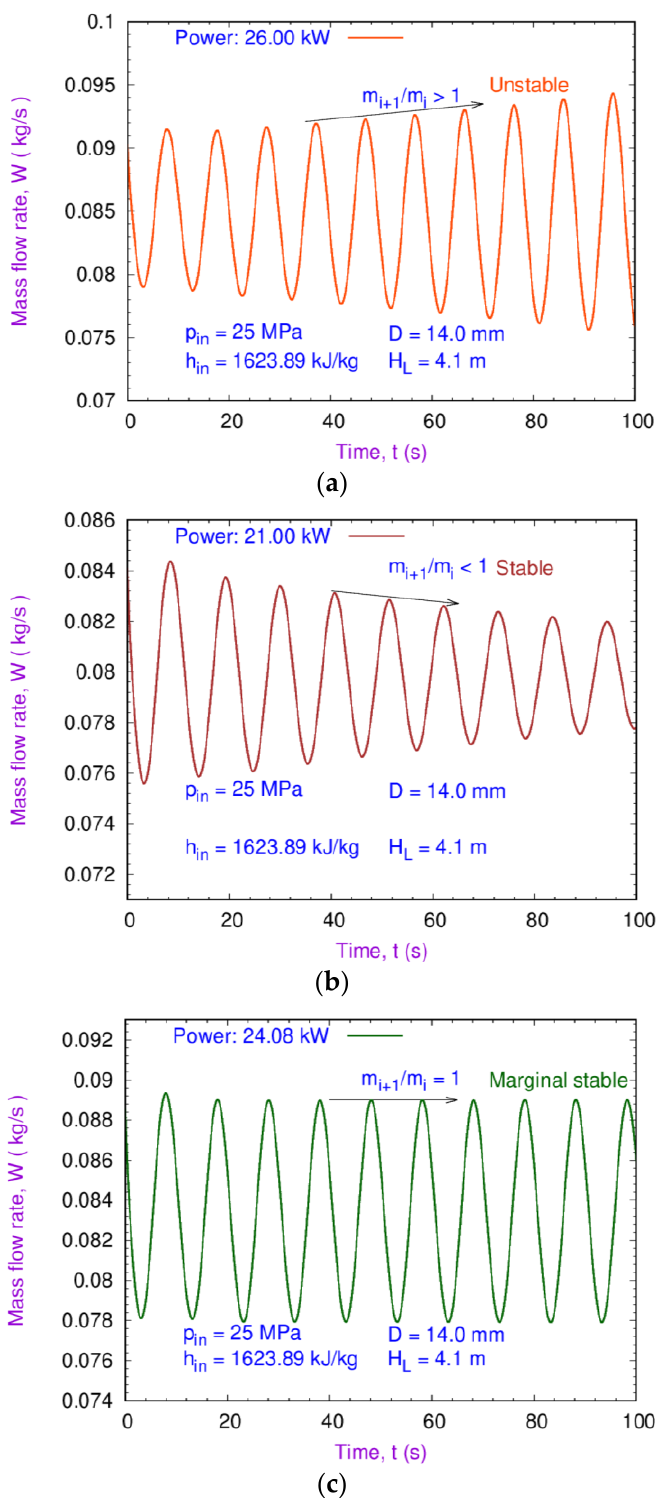
Figure 4. Density wave instability phenomena of the loop: ( a ) unstable, ( b ) stable, and ( c ) marginal stability.